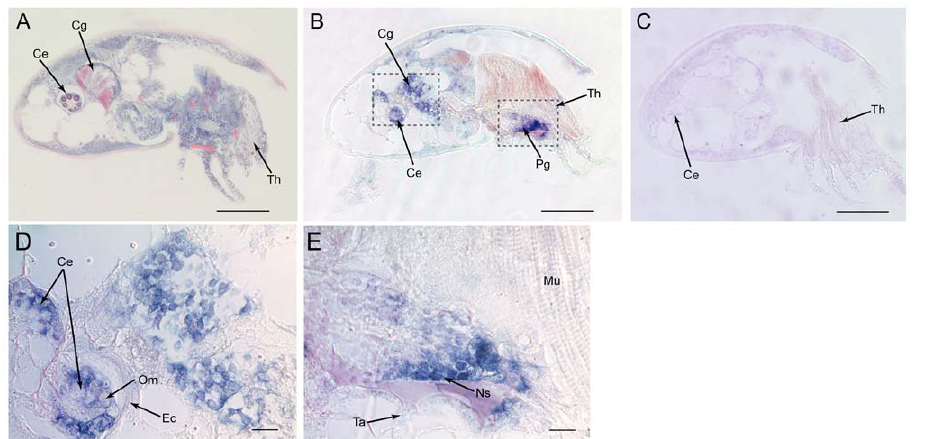
Figure 5. Ba-CaM spatial expression pattern in the sagittal sections of B.amphitrite cyprids. The HE staining image (A) shows a clear larval histology. Blue color stained by haematoxylin indicated nuclei, while red color by eosin indicated basic proteins or muscle fibers. Lenses of compound eyes and intracellular substances (maybe cement proteins) in the cement gland were stained by eosin. Positive signals were detected from the sections hybridized with the anti-sense probe (B). Section hybridized with the sense probe served as a control (C). (E) Detail of the cyprid compound eye and cement glands. (F) Detail of the cyprid posterior ganglion. Ce, compound eye; Cg, cement gland; Pg, posterior ganglion; Ta, thorax. Scale bars=100 m m.